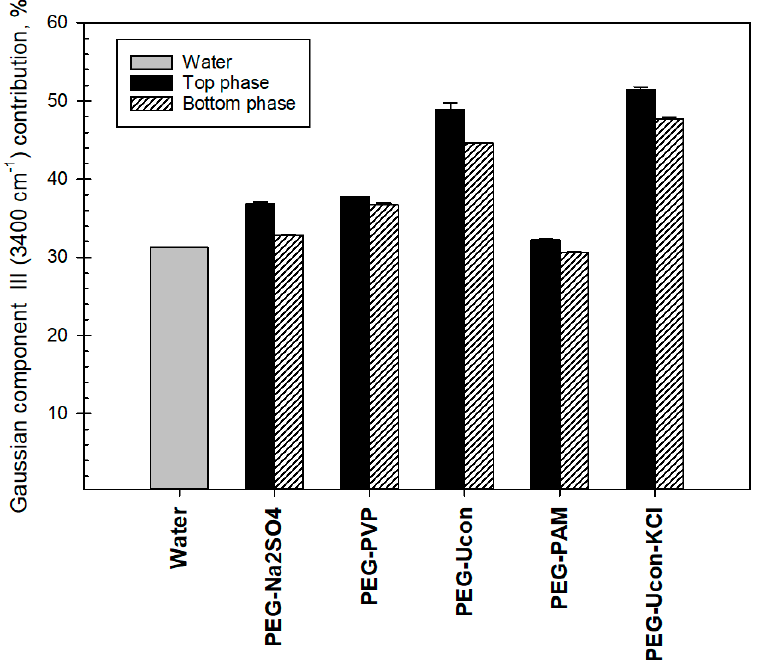
Figure 7. Differences between relative contributions (%) of Gaussian component III in the OH-stretch band of water in the phases (I 3400 cm − 1 ) of the aqueous two-phase systems indicated and contribution of the component III in pure water.